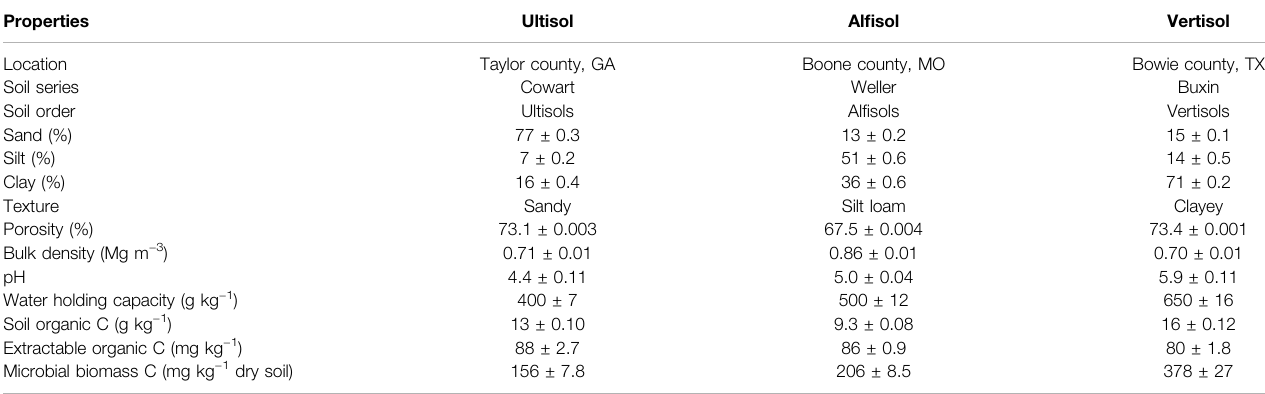
TABLE 1 | Properties of the soils used in the study.